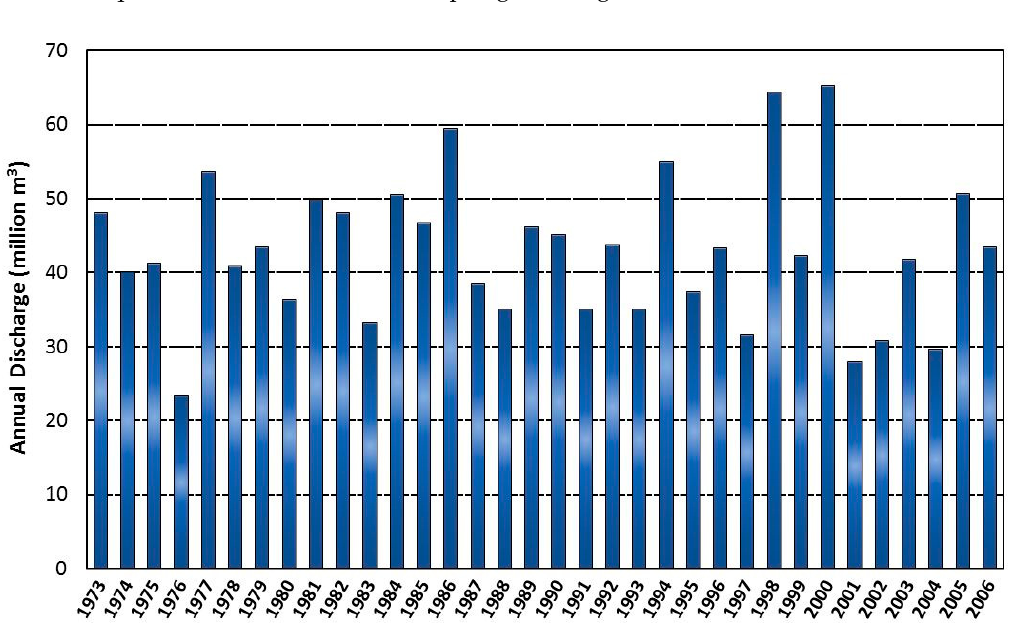
Figure 7. Annual dynamic reserves of Kourtaliotis spring.